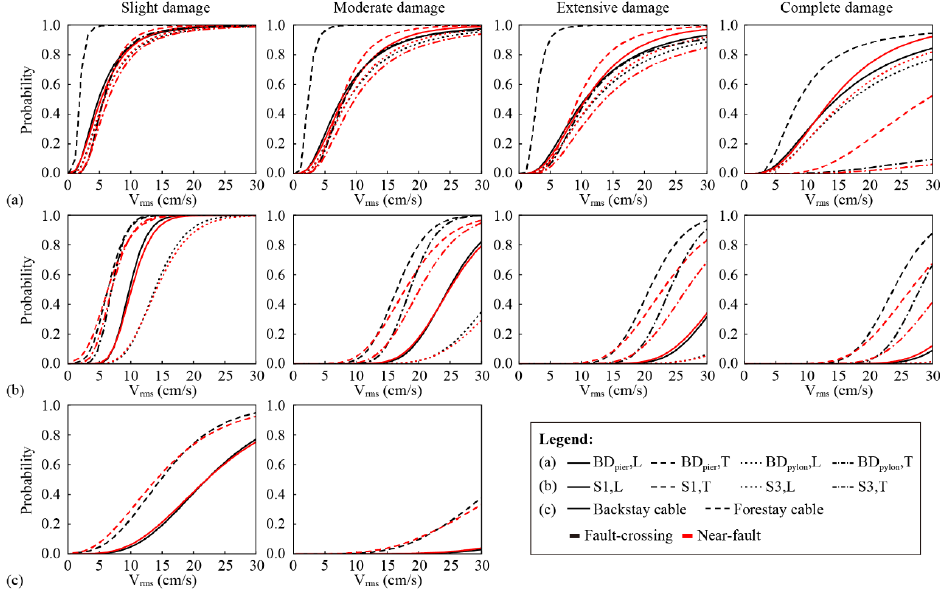
Figure 14. Comparison between the component fragility curves of fault-crossing and near-fault cable-stayed bridges for ( a ) bearings, ( b ) pylons, and ( c ) cables. Table 9. Median V rms across different damage states for fault-crossing and near-fault bridges (unit: cm/s).